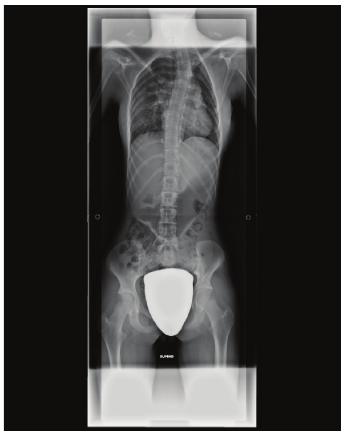
Figure 2: Chest radiograph (CXR) image. CXR shows a left cervical and right dorsal scoliosis with left deviation of sternum.